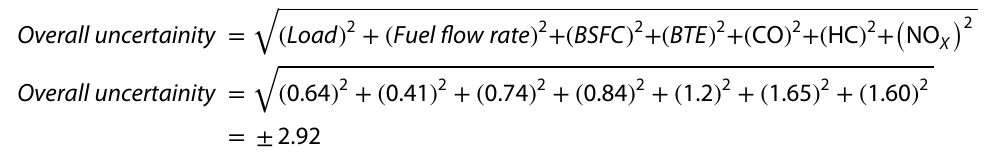
OIML class 0 and ISO3930 International standards.